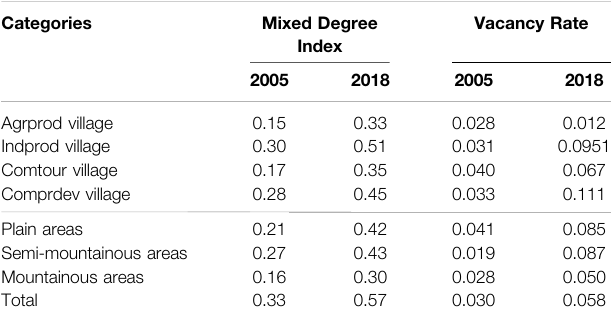
TABLE 4 | Characteristics of MLU and rural residential vacancy between 2005 and